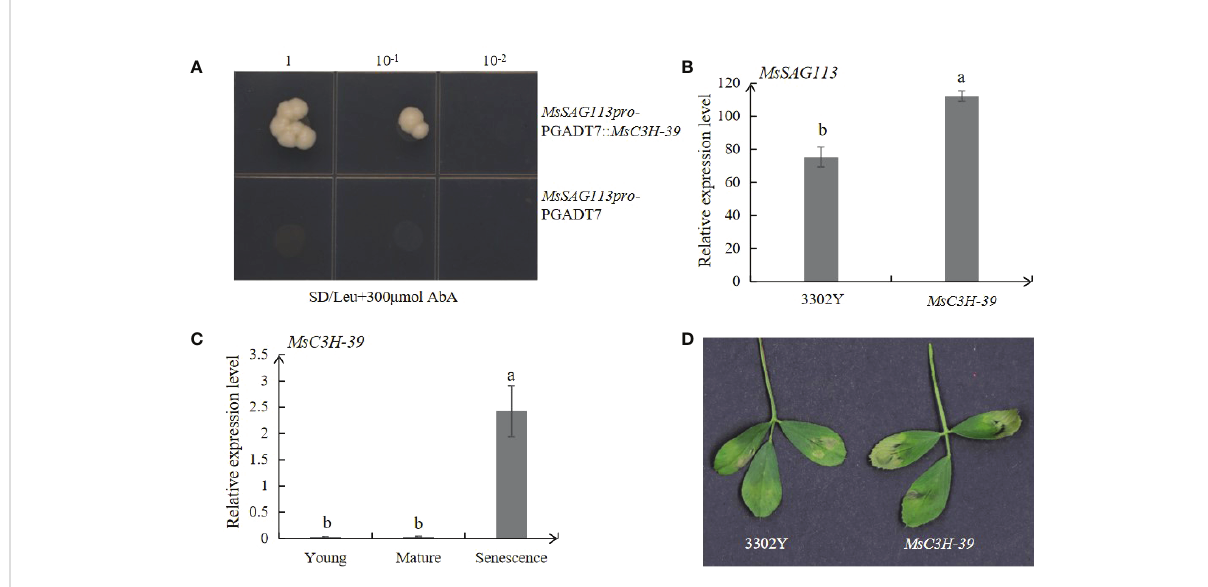
FIGURE 9 Interaction and expression analysis of MsSAG113 with TF MsC3H-39. (A) Interaction analysis of upstream of MsSAG113 and MsC3H-39 transcription factors. The number indicates dilution times of transformed yeast cells. (B) Relative expression levels of MsSAG113 gene in alfalfa with transcient expression of empty vector or MsC3H-39 . (C) Expression of MsC3H-39 in young, mature and senescent leaves of alfalfa. (D) 3302Y empty vector and MsC3H-39 transiently express the senescent phenotype in alfalfa leaves. The values are means ± SD (n = 3). In graphs, bars with different lowercase letters indicate signi fi cant difference at p<0.05.